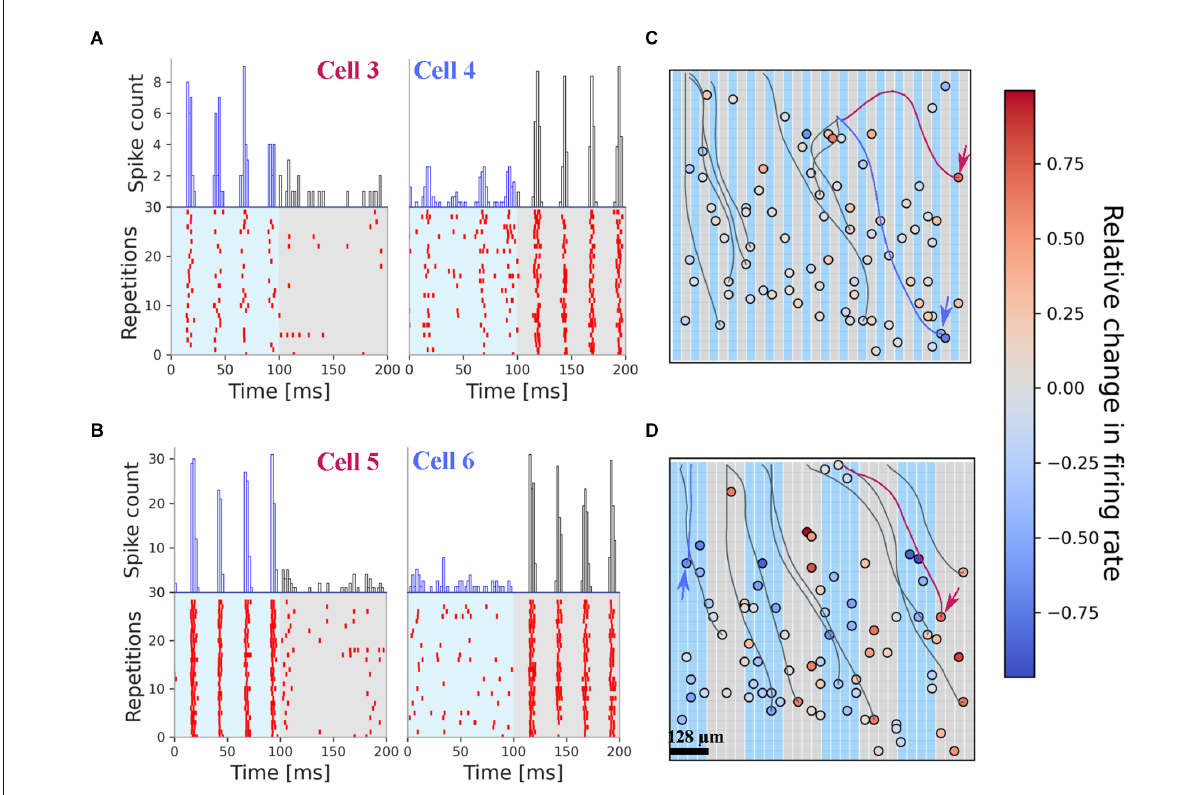
FIGURE3 Electrical stimulation with fine gratings evokes spatially restricted RGC spiking. All results presented here originate from one retina. (A) Rasterplot of two selected RGCs upon stimulation with fine grating stimuli (bar width: 32 µ m). Cell 3 is stimulated only in phase 1 (0–100 ms) while cell 4 is stimulated in phase 2 (100–200 ms). The cell positions are marked with arrows in panel (C) . (B) Rasterplot of two selected RGCs upon stimulation with grating stimuli (bar width: 128 µ m). The spiking pattern for each cell is confined to one phase. The cell positions are marked with arrows in panel (D) . (C) Positions of the RGC on the stimulation array. Color-coded is the relative change in firing rate. The background colors of the grating mark the electrodes used in phase 1 and phase 2. The results presented here were obtained after stimulation with 32 µ m narrow gratings (panel A ). For visualization purposes, only a few axons are shown. (D) Positions of the RGC on the stimulation array, with the corresponding color coding of the relative change in firing rate. Note the dominant red colors on top of the gray stimulation electrodes indicating selective activation by this